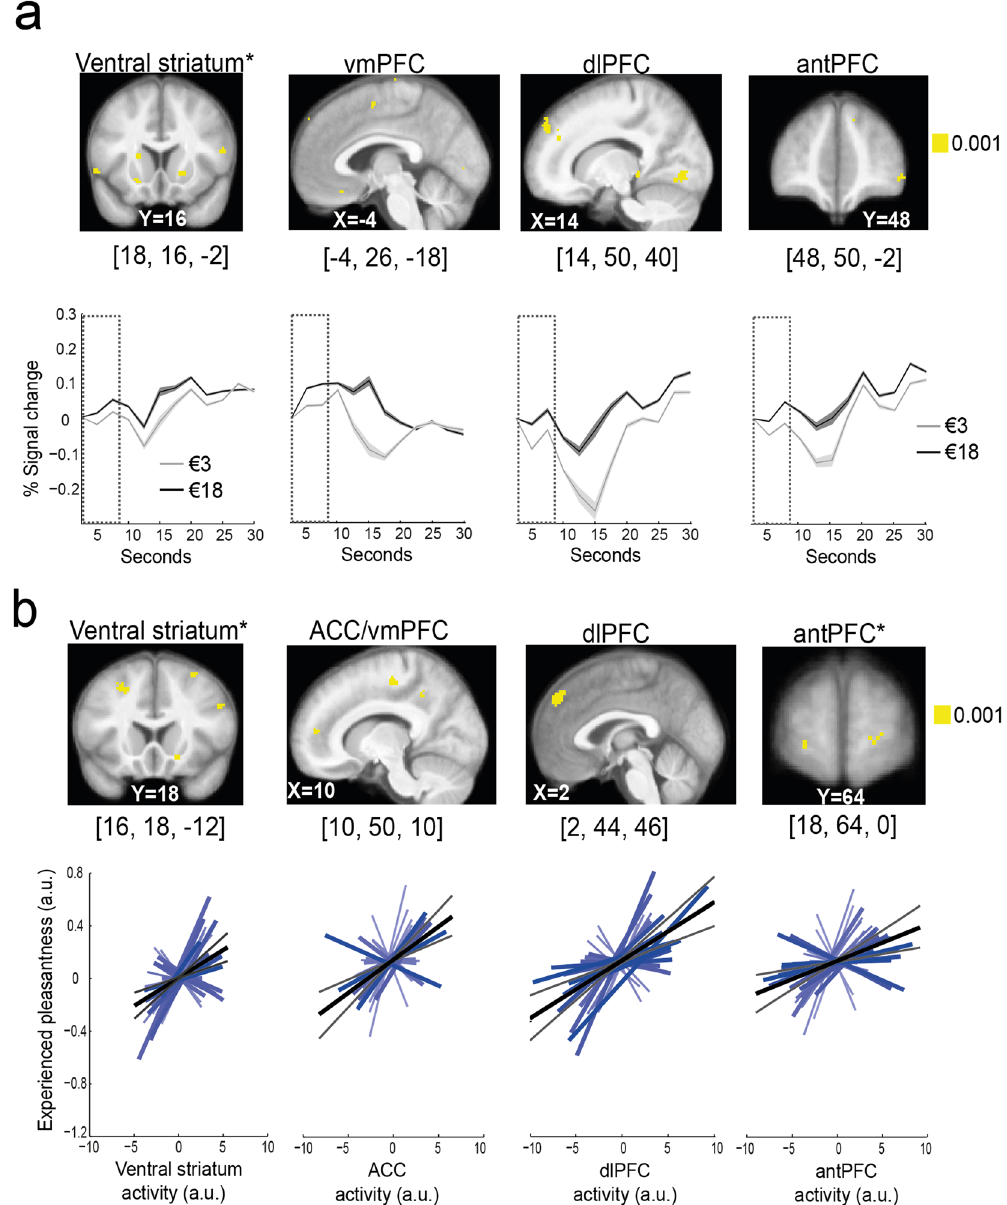
Figure 2. Brain responses to price cue and experienced pleasantness ratings averaged across N = 30 participants ( * p FWE < 0.05). Significant voxels are displayed for visualization purposes in yellow at p < 0.001 uncorrected, and are superimposed on the average anatomical brain image. The [ x , y , z ] coordinates correspond to MNI coordinates and are taken at maxima of interest. ( a ) Path a: price cue–related effect on brain activity. The line graphs depict time courses across seconds for activations in the reported [ x , y , z ] MNI coordinates. The dotted squares denote the 8-second-long wine tasting period. Shaded errors represent confidence intervals (means ± intersubject SEM). ( b ) Path b: brain activity underpinning experienced pleasantness ratings. Line graphs depict individual variations in path b coefficients (blue lines) with the group regression slope (grey line) for the activations in the reported [ x , y , z ] MNI coordinates. Grey lines represent confidence intervals (95%). ACC/vmPFC: anterior cingulate cortex/ventromedial prefrontal cortex; antPFC: anterior prefrontal cortex; dlPFC: dorsolateral prefrontal